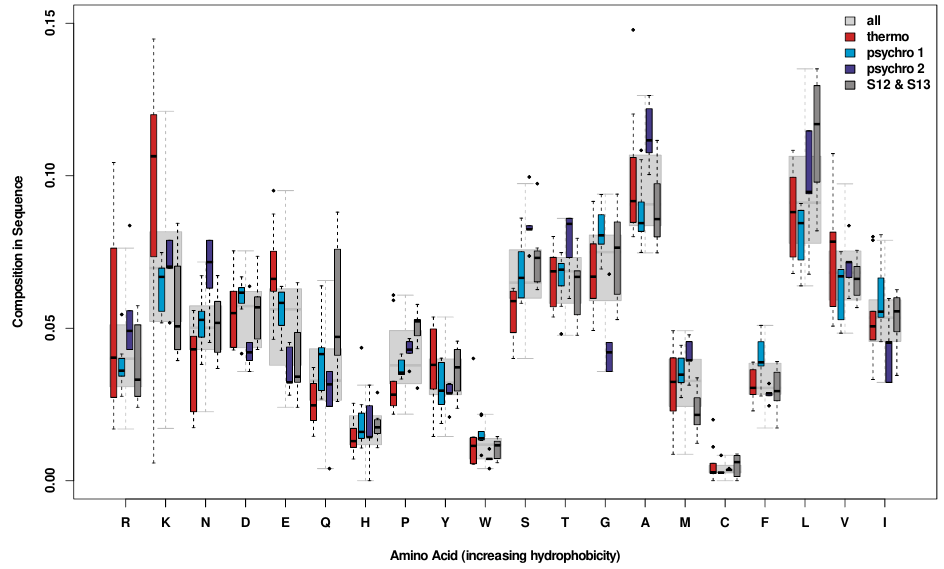
Figure 2. Amino acid compositions normalized by sequence length and by thermal group. Figure 3 shows the amino acid composition grouped by type. Here, we observe a greater concentration of uncharged polar residues in psychrophiles. Both positively and negatively charged residues (R, K, D, and E) have a higher abundance in thermophiles, potentially allowing for more stabilizing salt bridges; we investigate this possibility below.